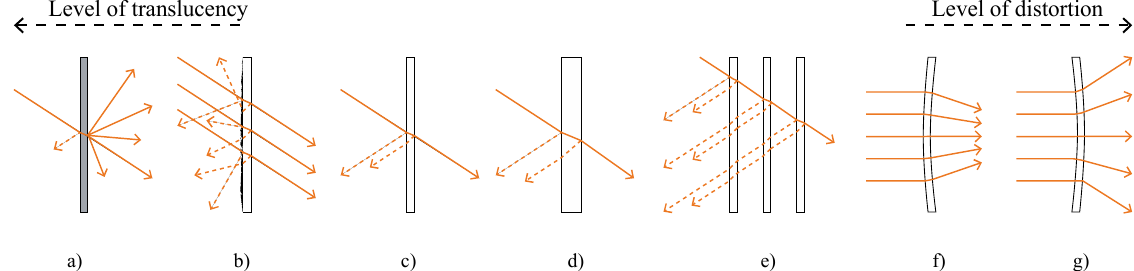
Fig. 7 Degrees of optical illusions related to the surface treatment, geometry and configuration of the glass elements: a) Translucent surface diffuses the light and allows for a perception of the surroundings in a certain distance, b) Textured surface allows for the perception of the surroundings with limited clarity, c) Thin flat glass has the maximum level of transparency and minimum distortion, d) Thick cast glass has a little lower level of transparency compared to thin glass, e) Configuration with mulptiple layers can create a great number of reflections dirtorting the perceived image, f) Convex curved glass results in barrel distortion of the perceied image and g) Concave curved glass results in pincushion distortion of the perceived